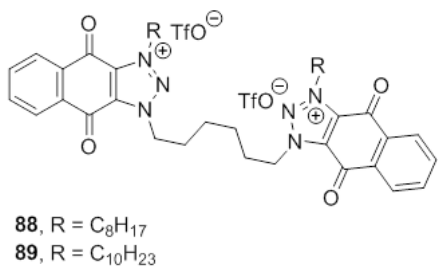
Figure 7 - (Entry 88 – 89) – Dimeric